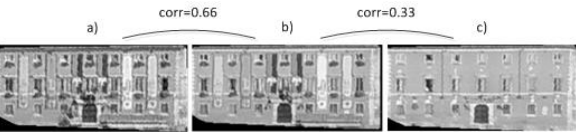
Figure 16. Changes not hazard related. Same façade extracted from both epochs. a) and b) relative to pre-event and c) post event.